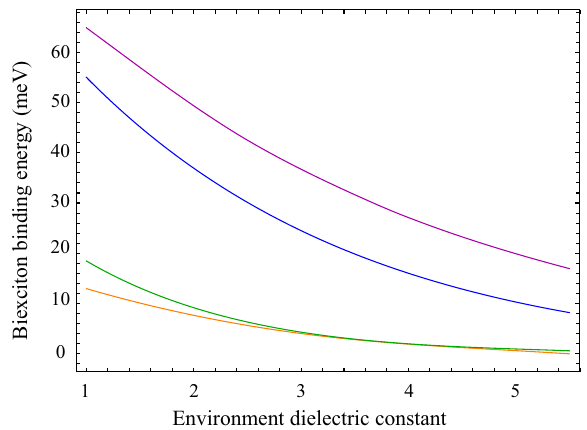
Fig. 4 Variation of the intervalley biexciton binding energy with environment screening. The lines come from the interpolation between multiple points calculated with the use of Eqs. 22 and 17. As in Figs. 2 and 3, the orange line is for ML WSe 2 , green line — ML WS 2 , blue line — ML MoS 2 , and purple line – ML MoSe 2